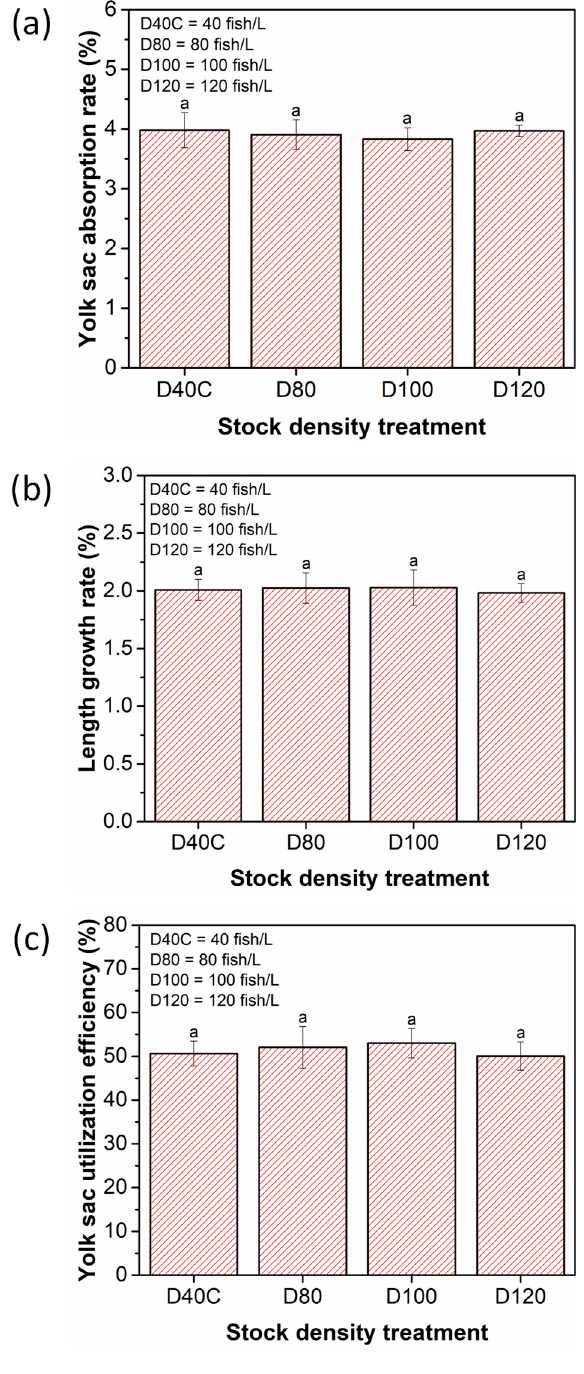
Figure 4. ( a ) Yolk sac absorption rate, ( b ) length growth rate, and ( c ) yolk sac utilization efficiency of striped catfish ( Pangasianodon hypophthalmus ) larvae at various stock density treatment levels in endogenous stage, at a mean temperature of 26.08 °C. Vertical bars indicate standard error, the same letters “a” denote no different ( p > 0.05).